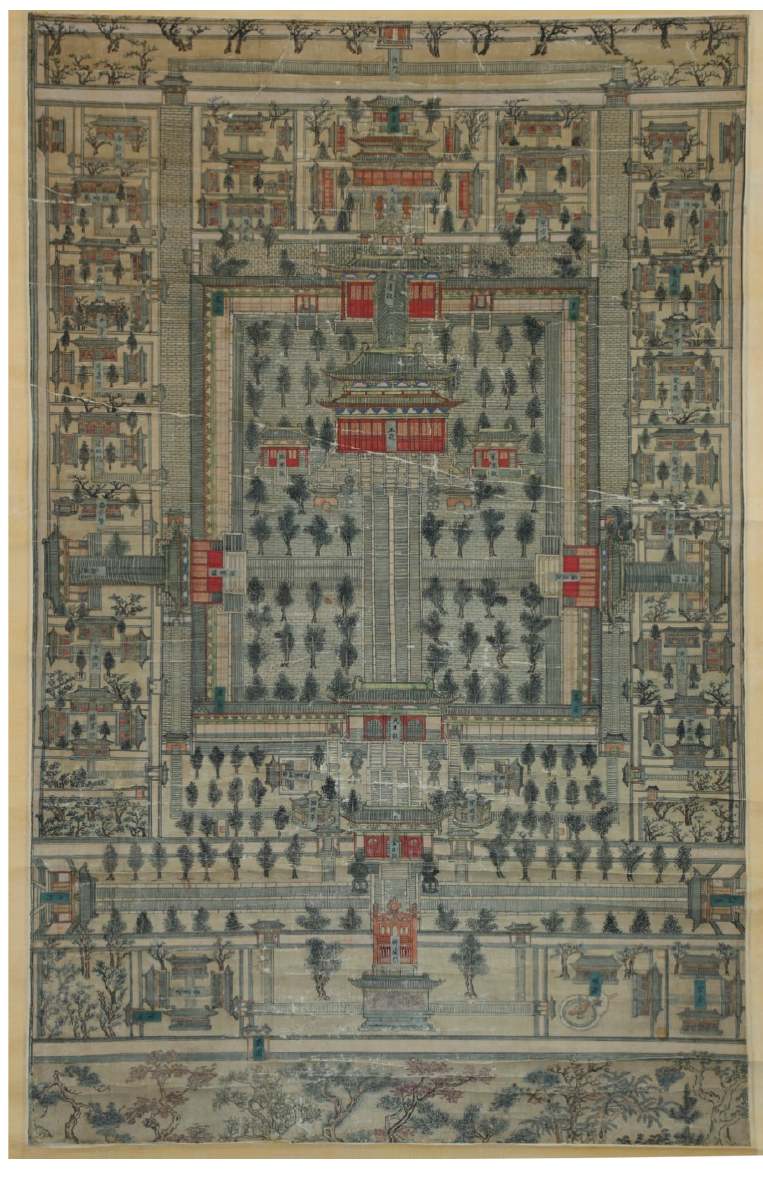
Figure 4. The Plan of Chongshansi (photo by author, 25 November 2020).